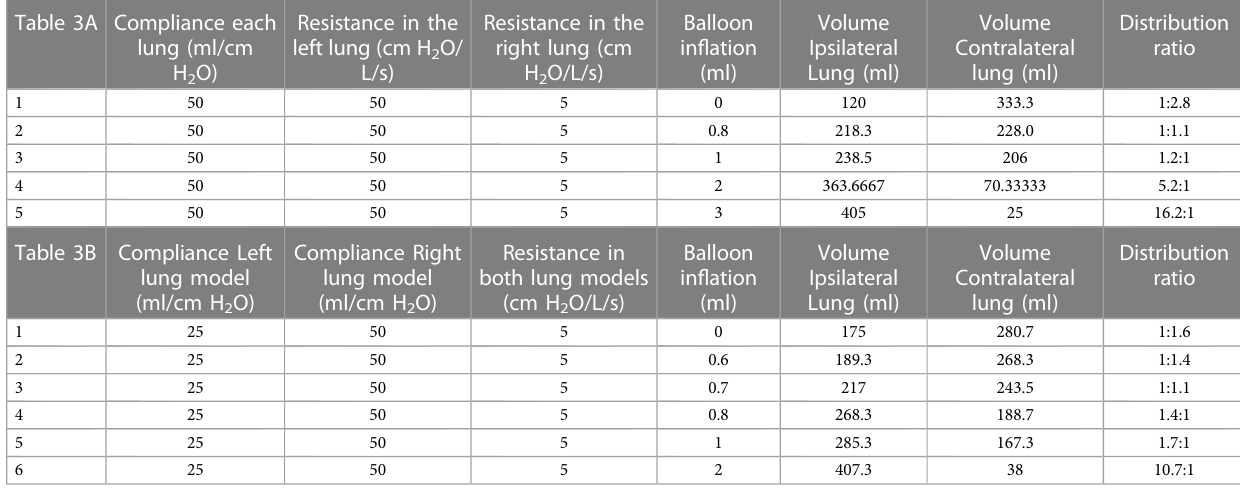
TABLE 3 The effect of volume correction in asymmetric lung injury. Table 3A Compliance each lung (ml/cm